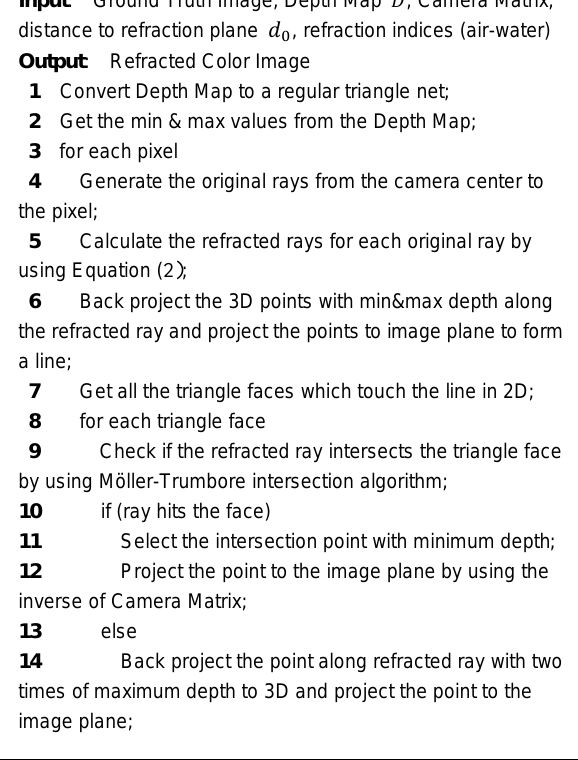
Figure 6. Pseudo-code of underwater refraction simulation